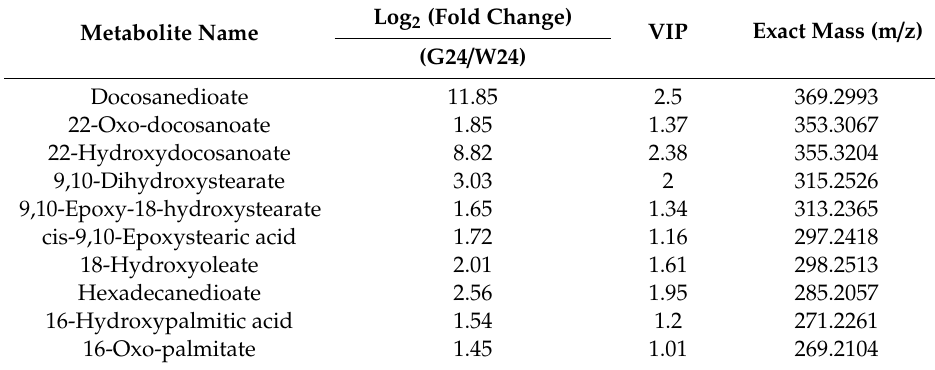
Table 2. Upregulated metabolites of the cutin, suberin, and wax biosynthesis pathway in G24 compared to W24.